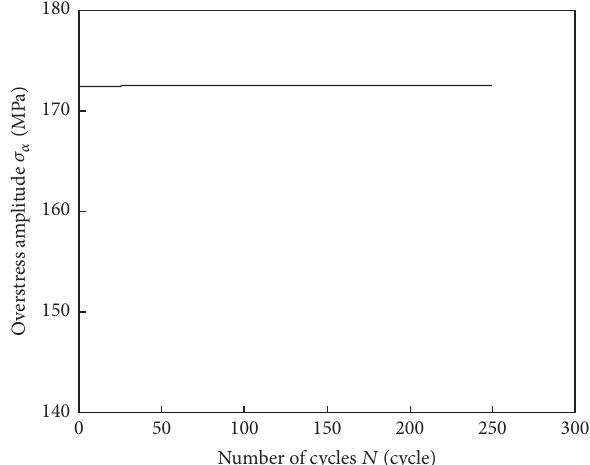
Figure 11: Number of cycle effects on overstress amplitude for a modified 9Cr-1Mo steel.